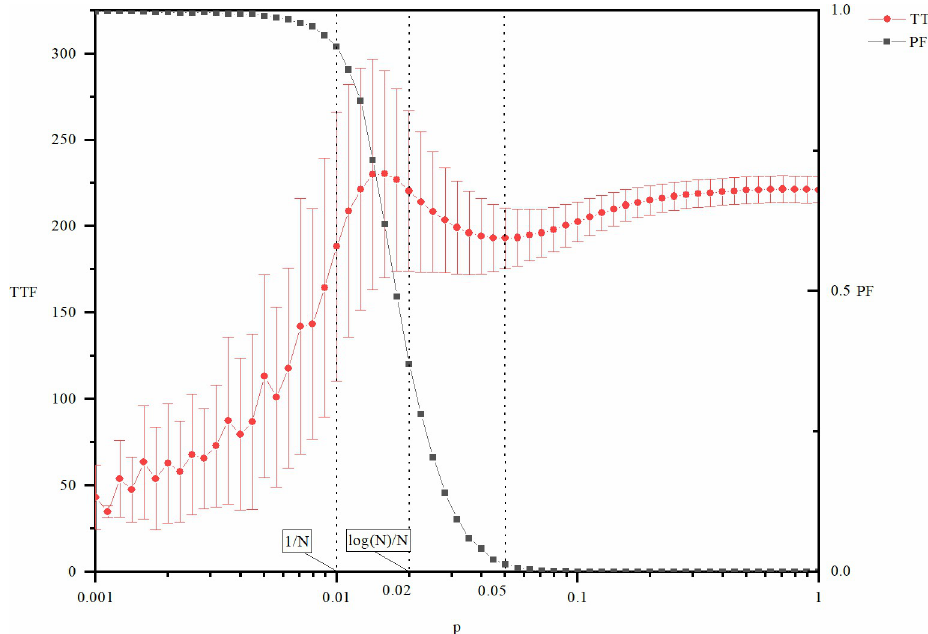
Fig 4. TTF and PF of exploitative innovation as a function of